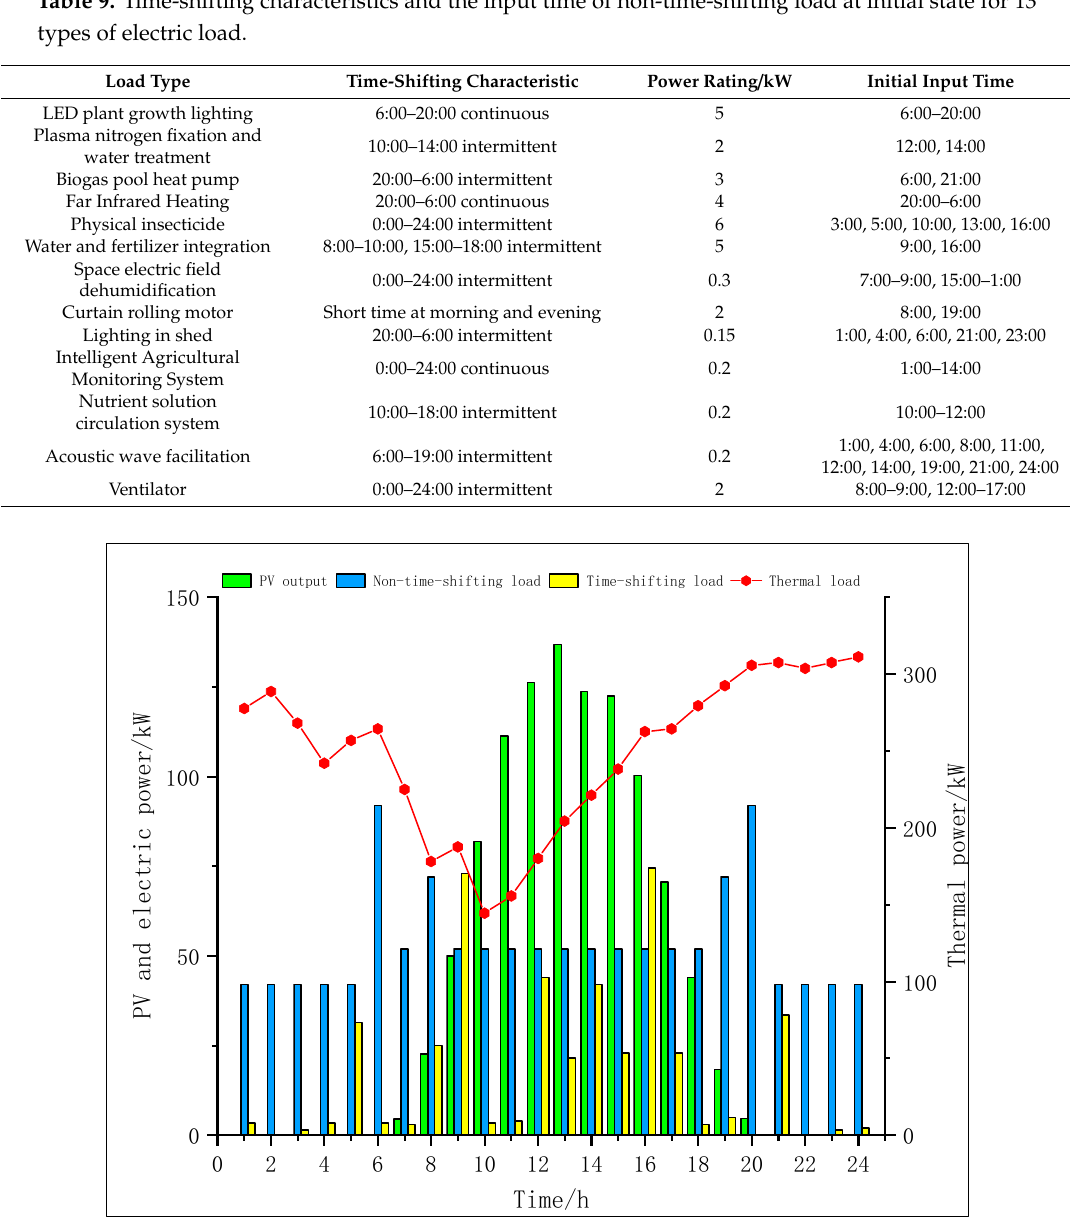
Figure 6. The PV output and three loads in greenhouse.